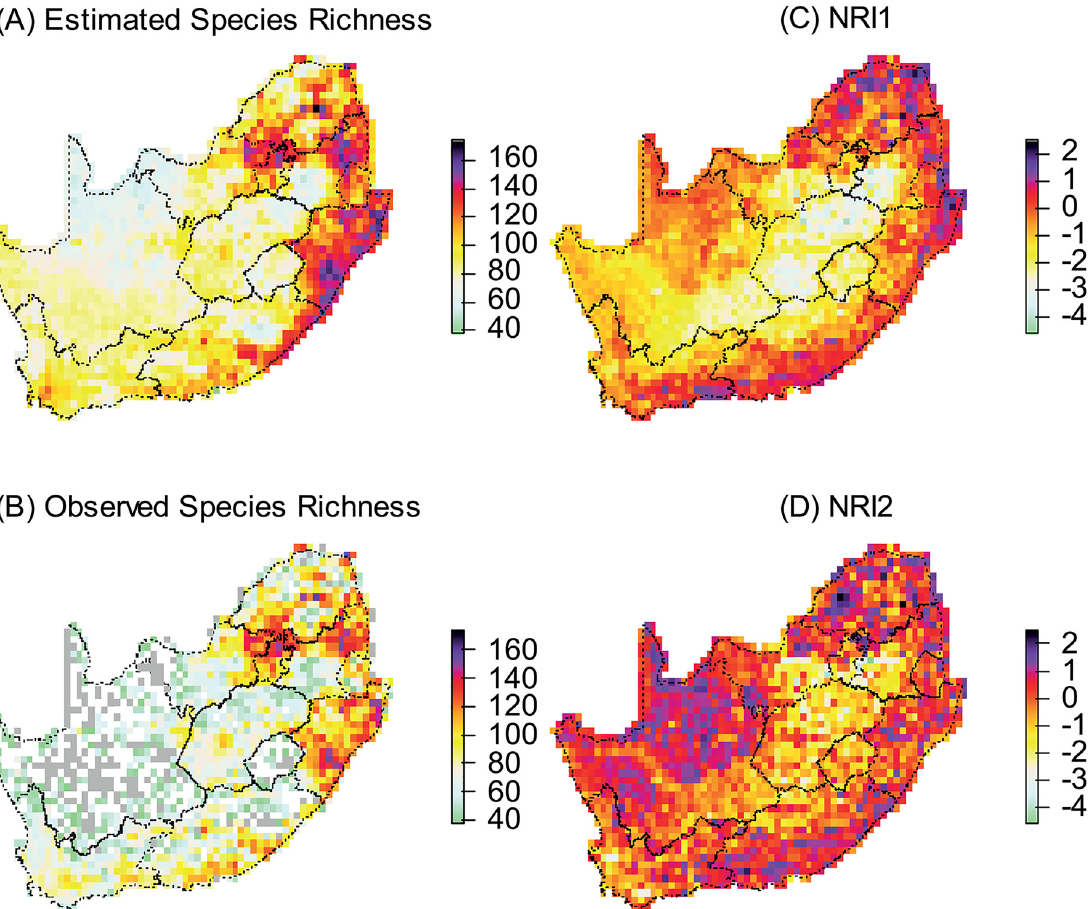
Fig 1. (A): Passerine species richness in South Africa corrected for imperfect sampling. (B): Species richness raw data (number of observed species, not corrected for imperfect sampling). Grey areas were not visited during SABAP2. (C) Taxonomic dispersion under null model